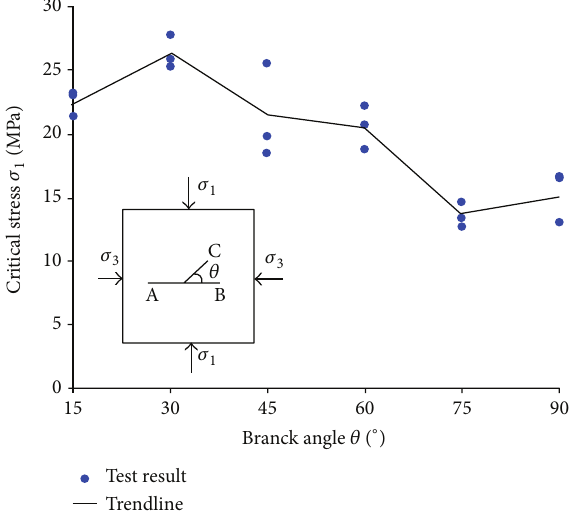
Figure 4: Test result for the relation between the critical stress and branch crack angles 𝜃